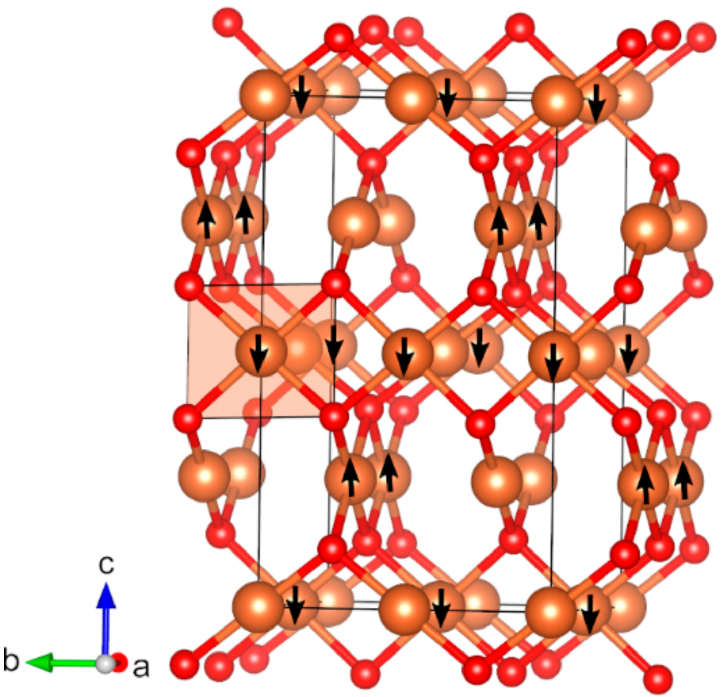
Figure 8. Optimized structure of Cu 4 O 3 ( tI 28) (red: O, light brown: Cu). The directions of magnetic moments are illustrated by black arrows. Coordination square planar of Cu atoms that are shown is a light-brown